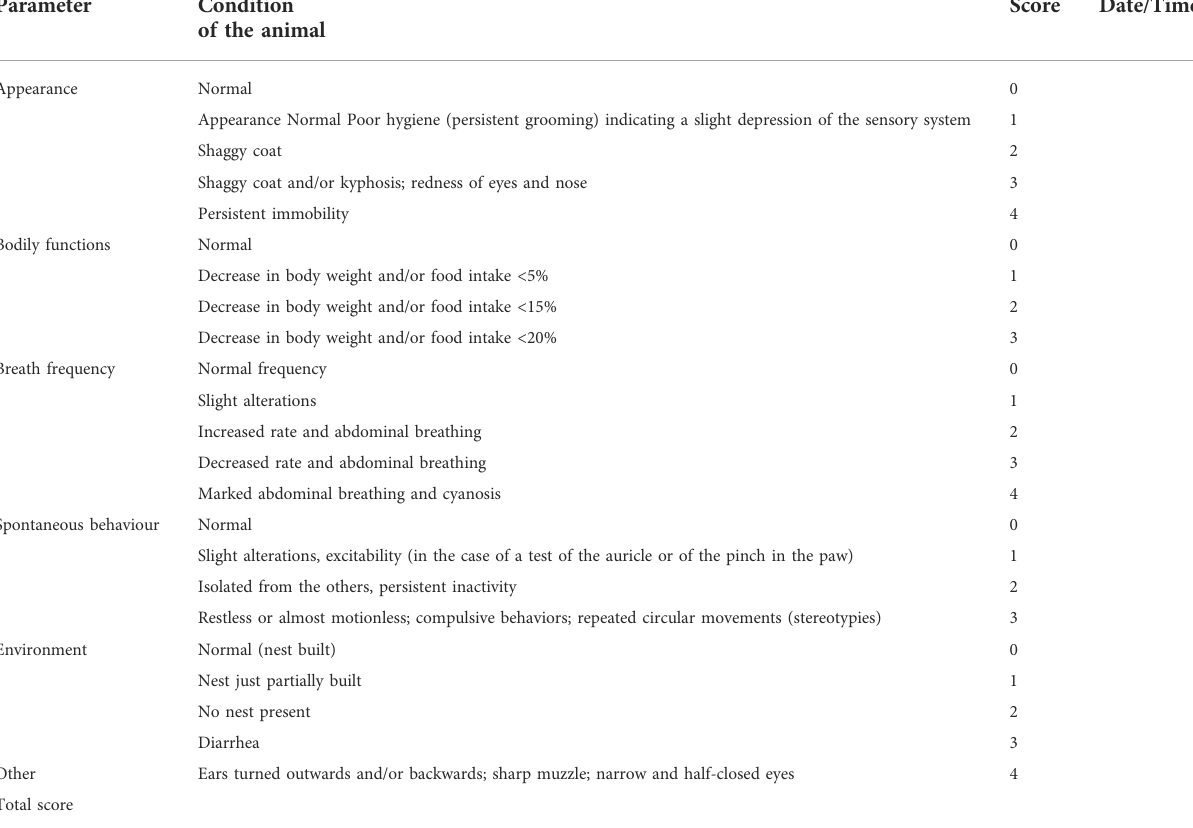
TABLE 1 Standardized scores for the assessment of suffering and the determination of “ humane endpoint ” in